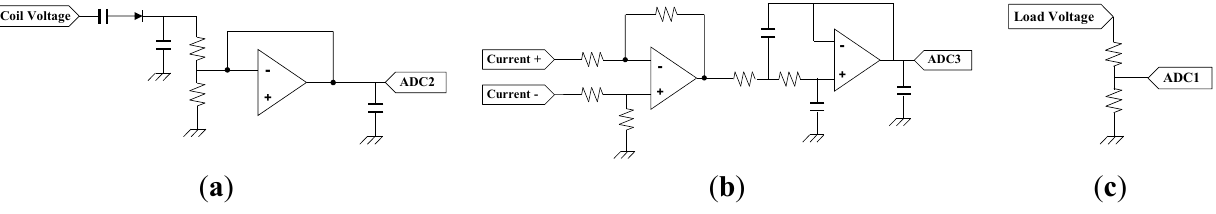
Figure 4. Schematic of three sensors. ( a ) Coil voltage sensor. ( b ) Supply current sensor. ( c ) Load voltage